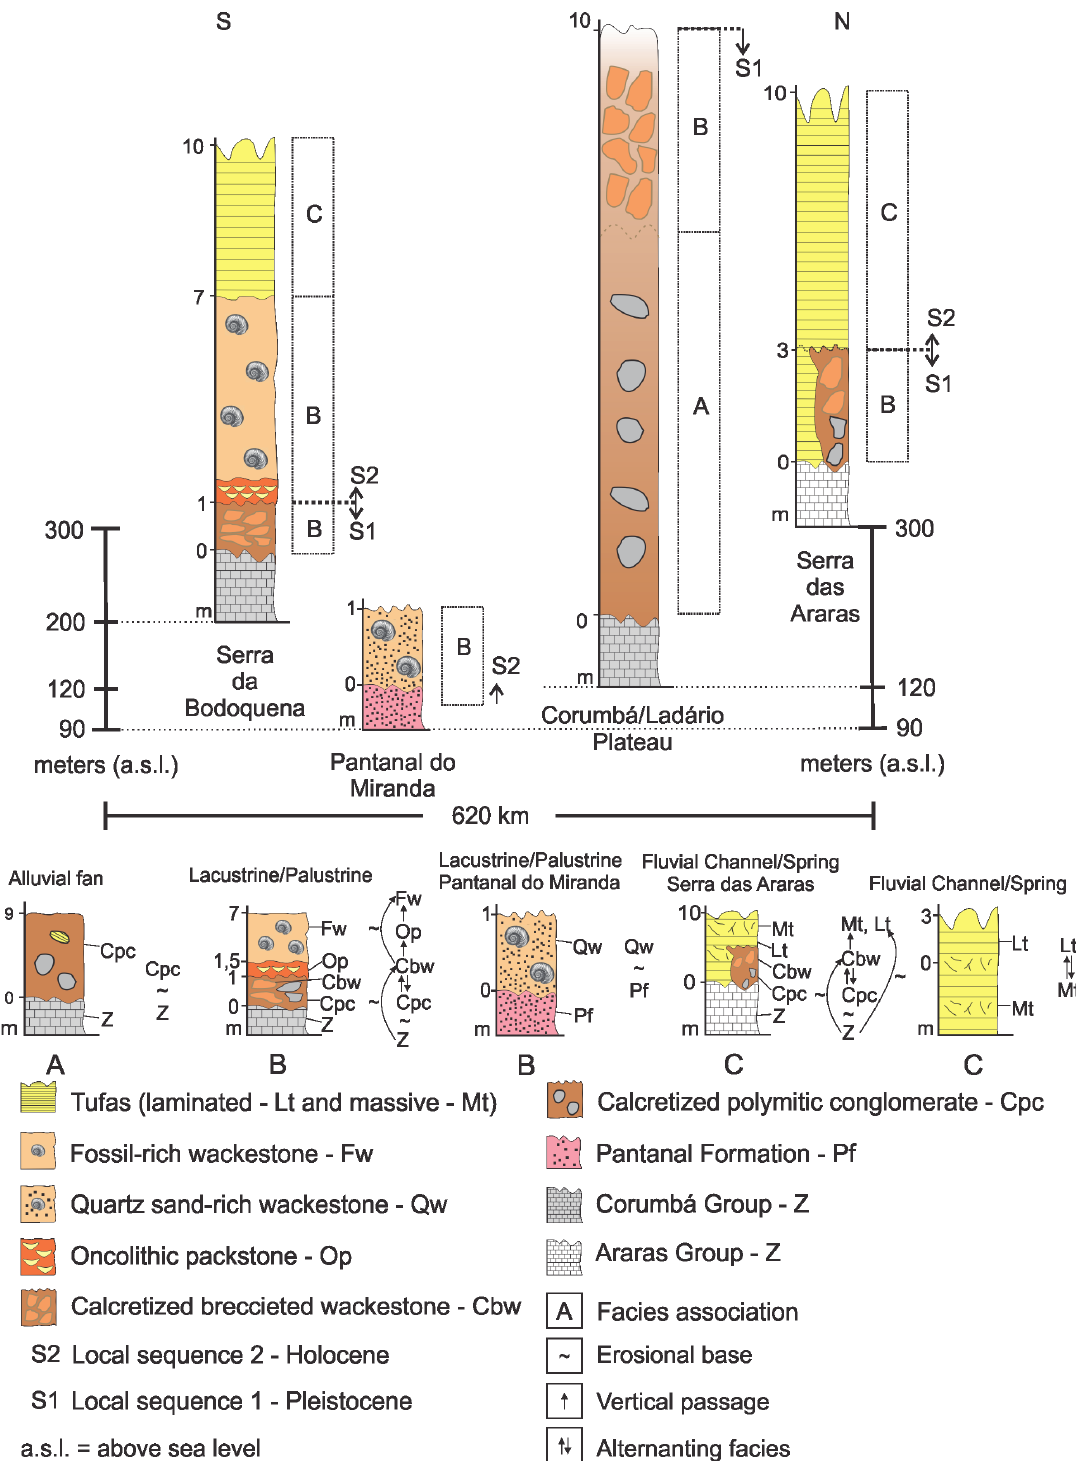
Figure 2 - Composite stratigraphic sections of the studied areas, with facies association representative of the different environments present in the studied area, without stratigraphic